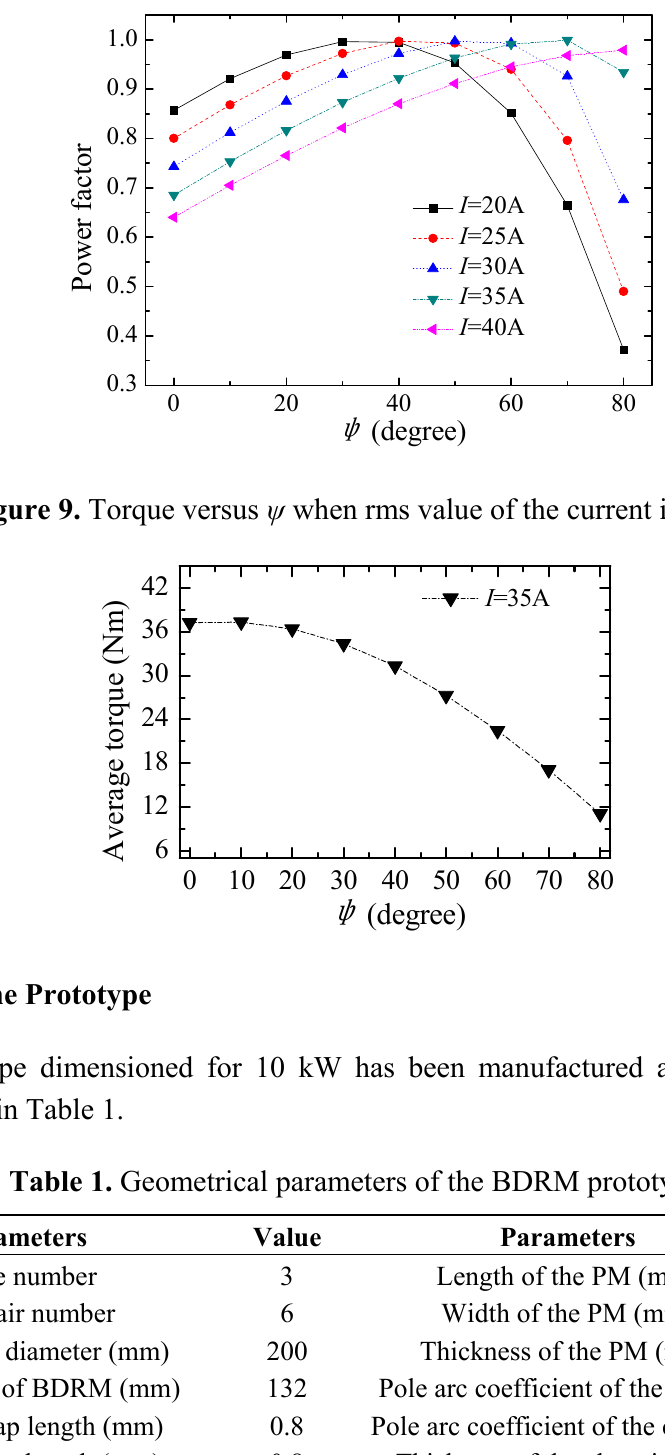
Figure 8. Variation of power factor versus ψ under different stator current conditions.